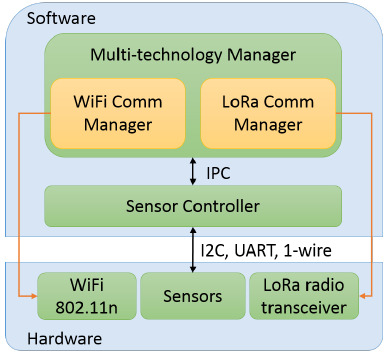
Figure 2. Data-collecting unit (DCU) software architecture. IPC: Inter-Process Communication; UART: Universal Asynchronous Receiver-Transmitter; I2C: Inter-Integrated